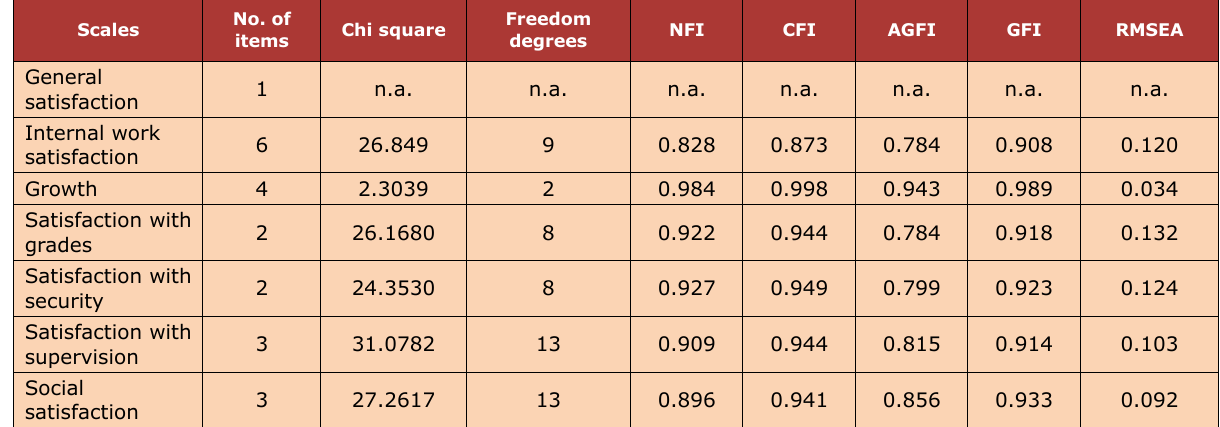
Table 6.Goodness of fit indices (n.a.= not